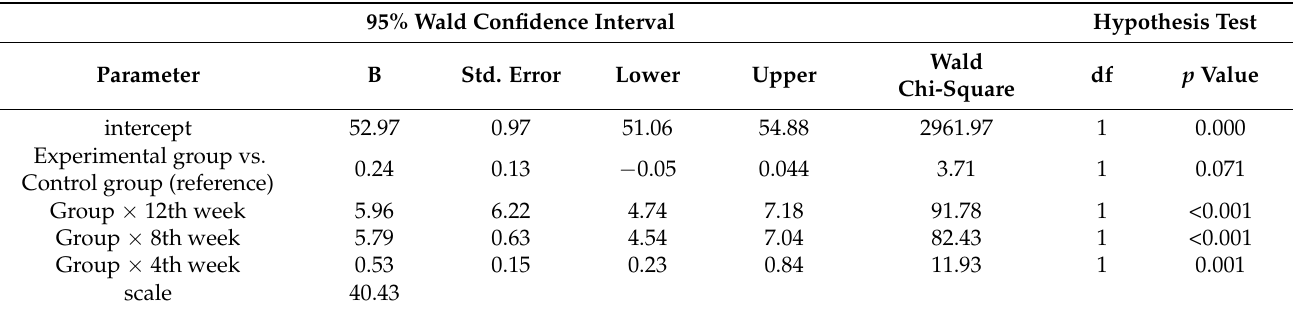
Table 4. Generalized estimating equation analysis of sense of coherence score in the experimental and control groups before and after intervention. 95% Wald Confidence